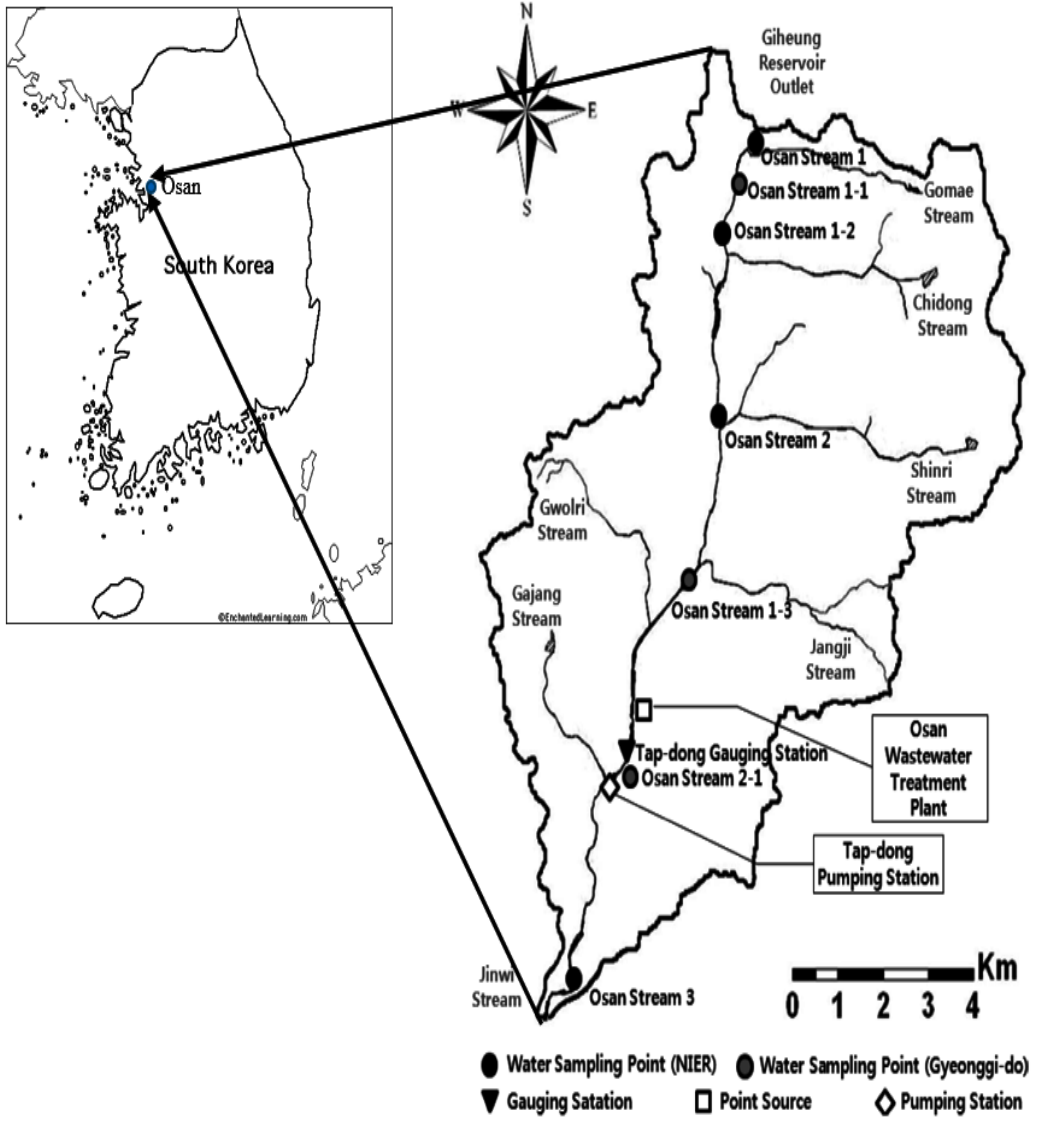
Figure 1. Location of the study